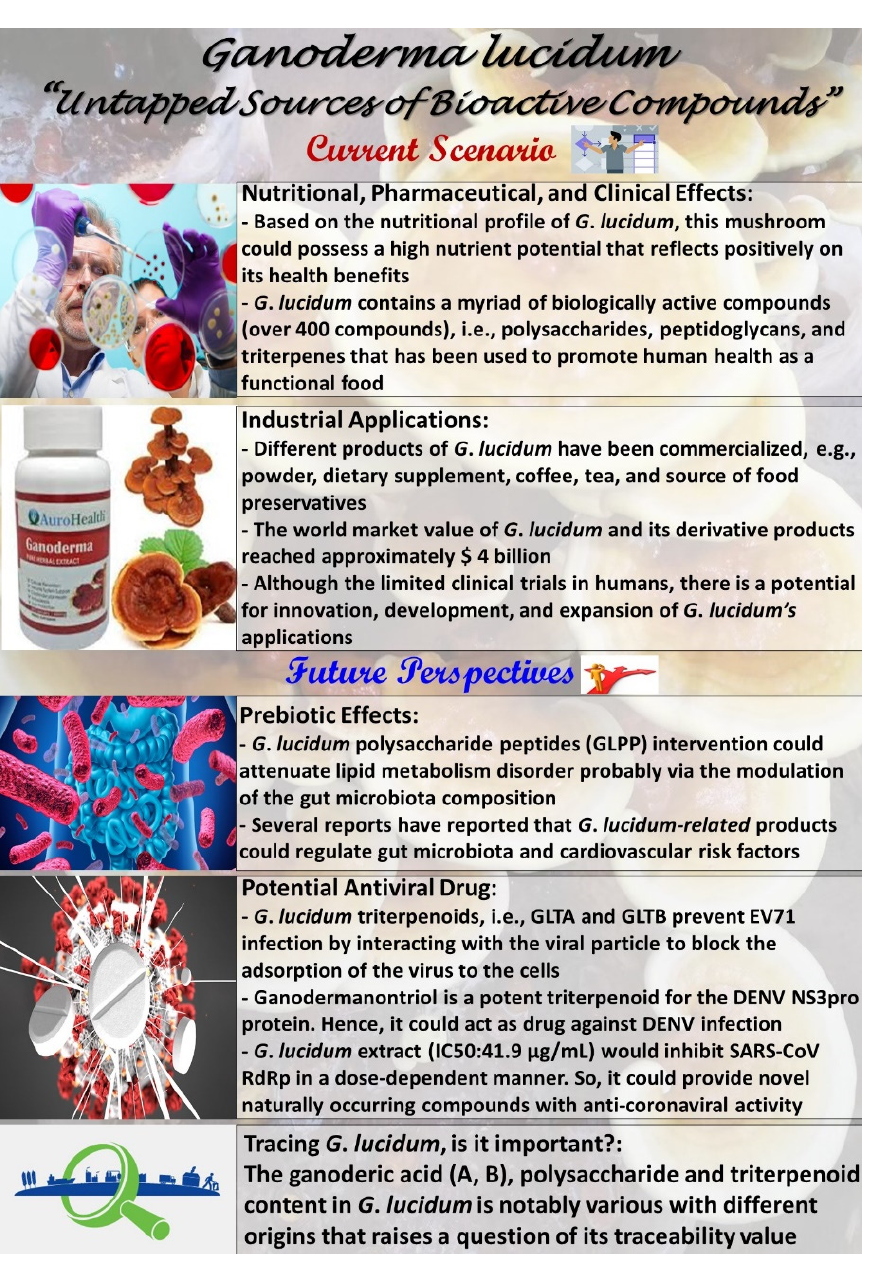
Figure 7. Infographic for Ganoderma lucidum : current scenario and future